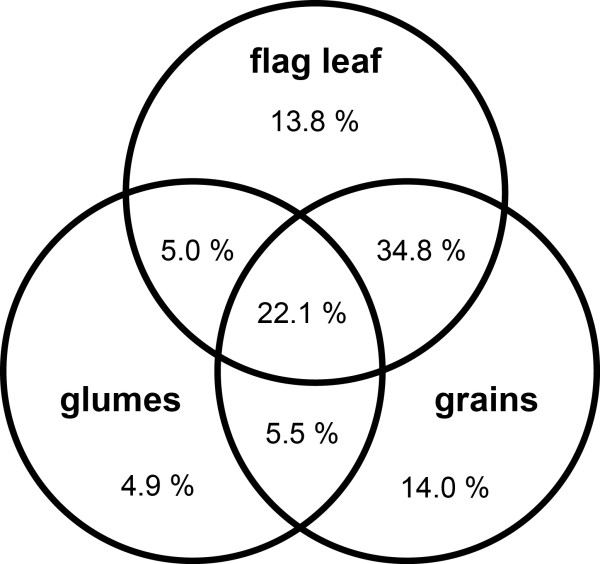
Venn diagram showing tissue specificity of the CAP3-contigs.